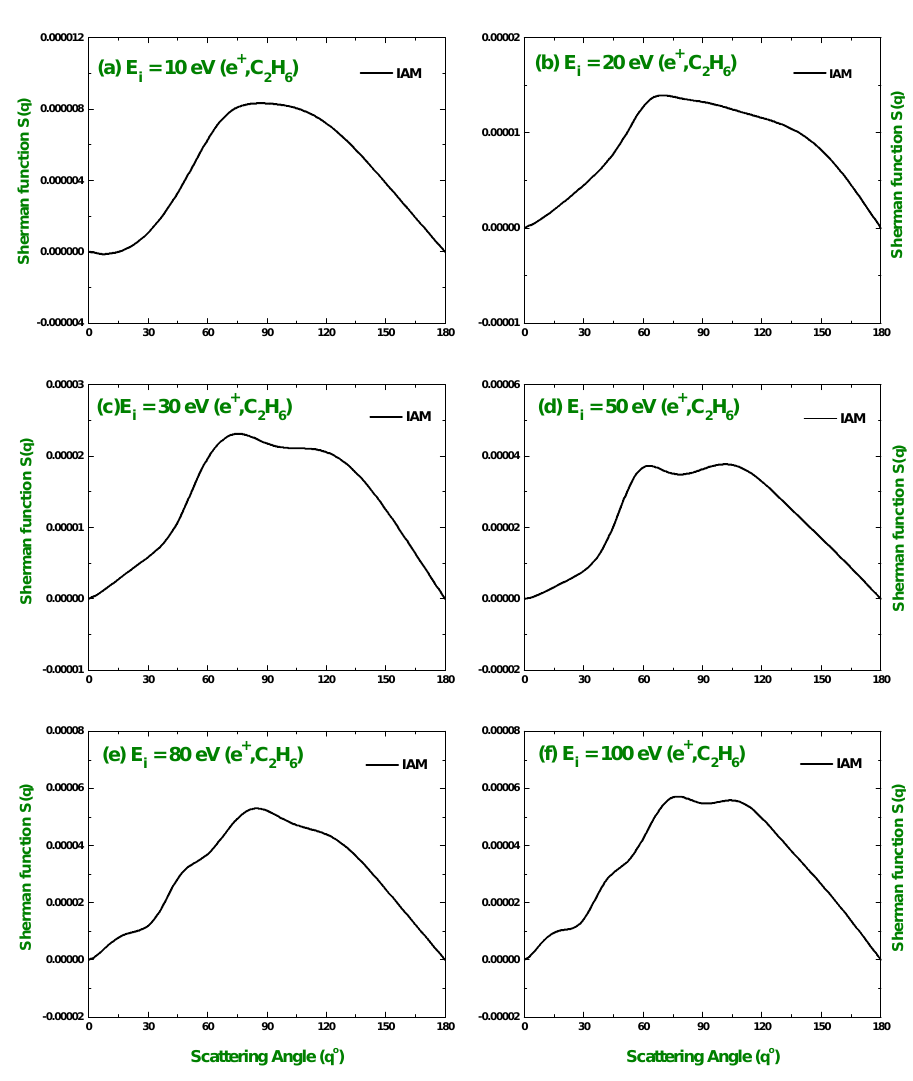
Figure 9. Angular distribution of the Sherman function for the positrons scattered elastically from C 2 H 6 predicted by the IAM